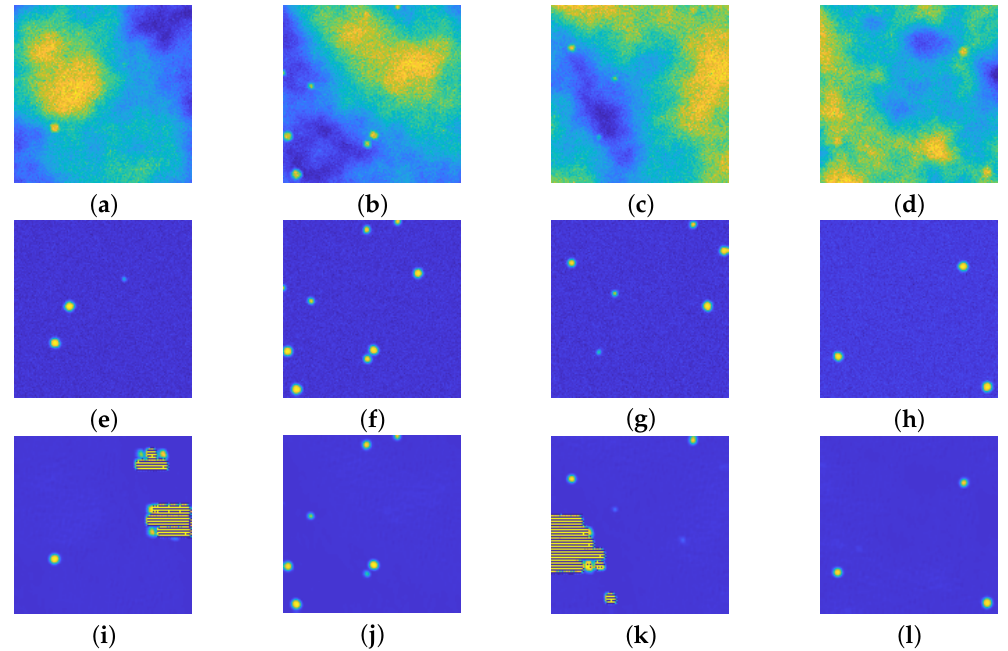
Figure 8. ( a – d ): Synthetic images. ( e – h ): ground truths. ( i – l ): recovered images via the U-net. This network is able to recover some of the images, but unfortunately it introduces some undesired artifacts. All the images are displayed with values in [ 0,255 ]